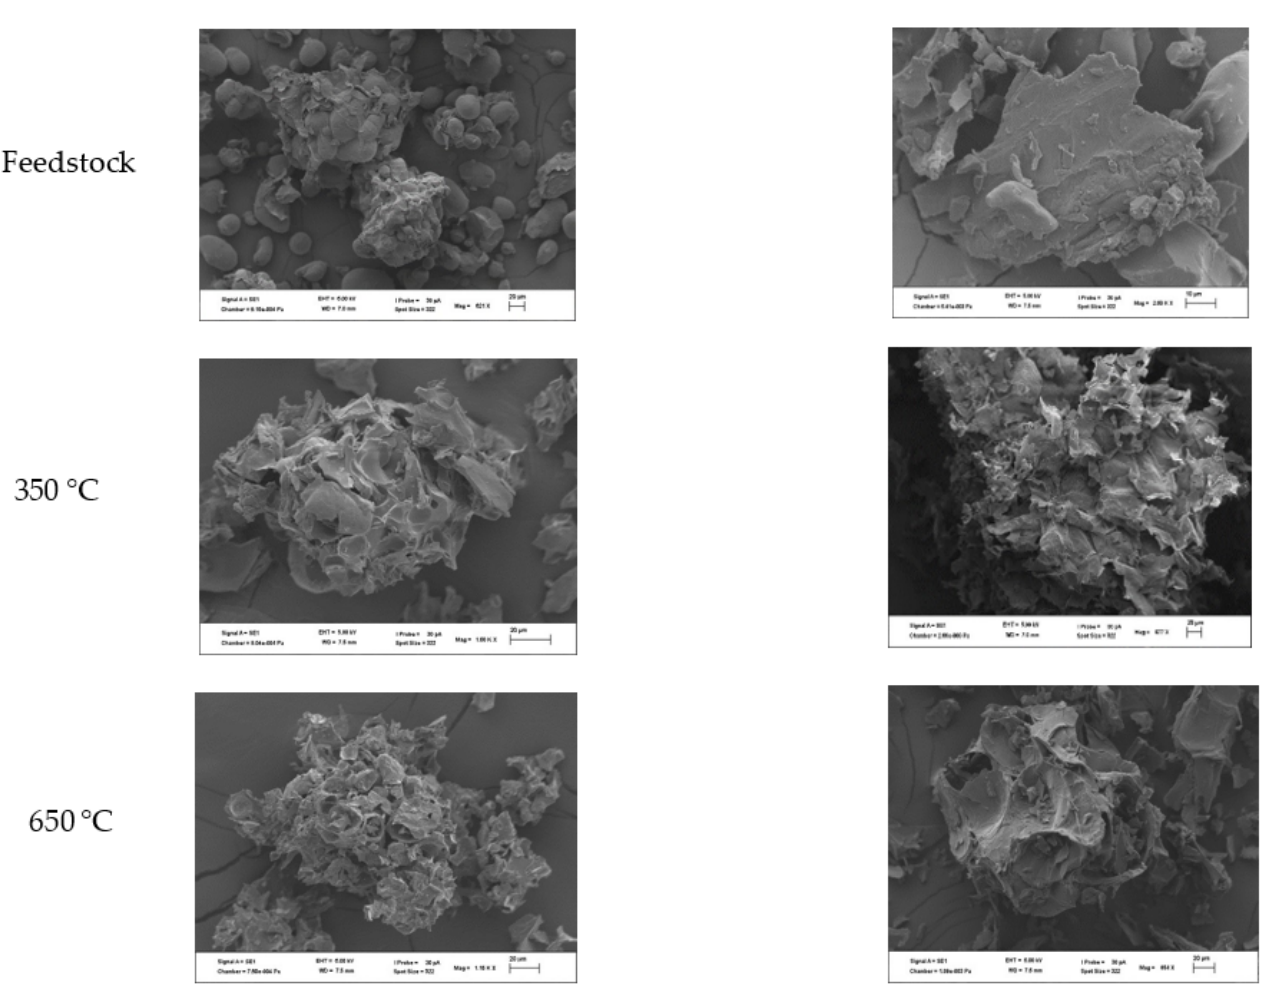
Figure 2. Morphological comparison of 4 studied biochars and their feedstocks at different pyrolysis temperatures using scanning electron microscopy. CP = cull potato waste; PB = pine bark.